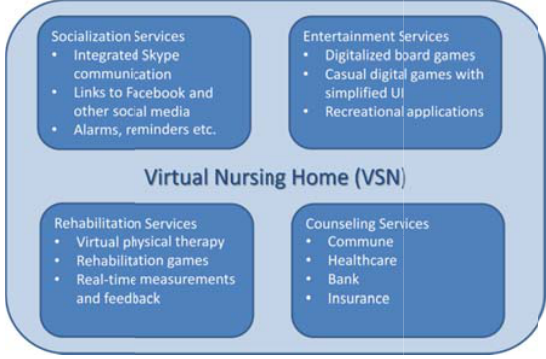
Patient-Ther Relationship Goal Setting Rehabilitativ Setting and Environmen Information Healthcare